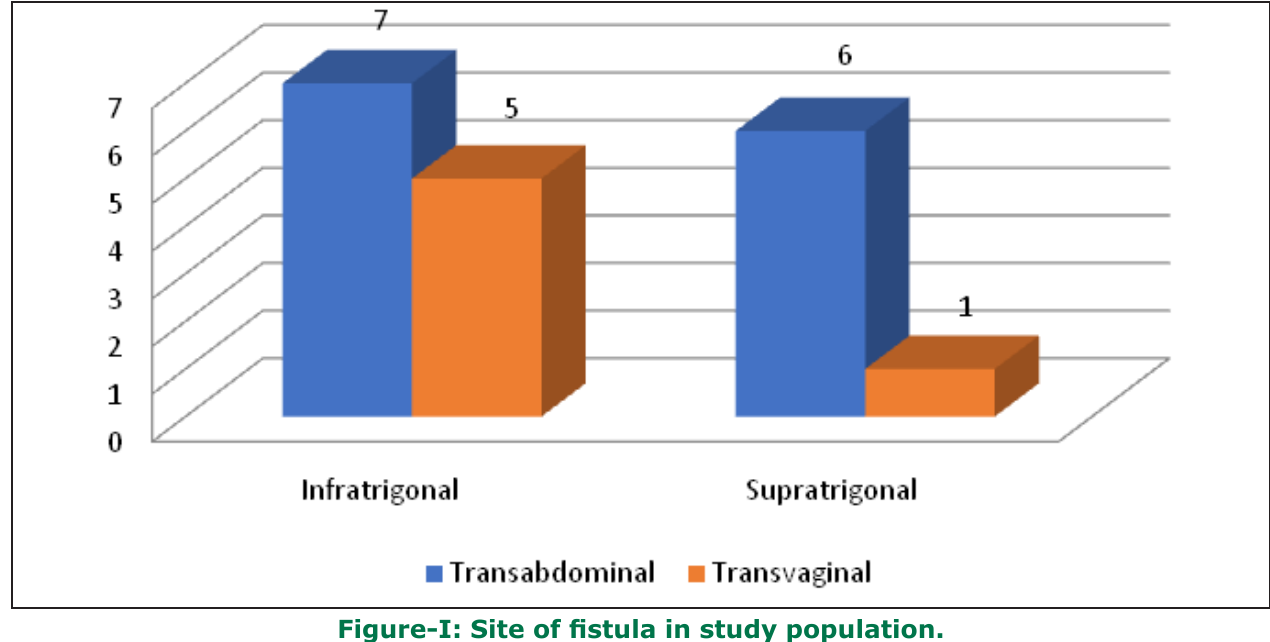
Figure-I: Site of fistula in study population.